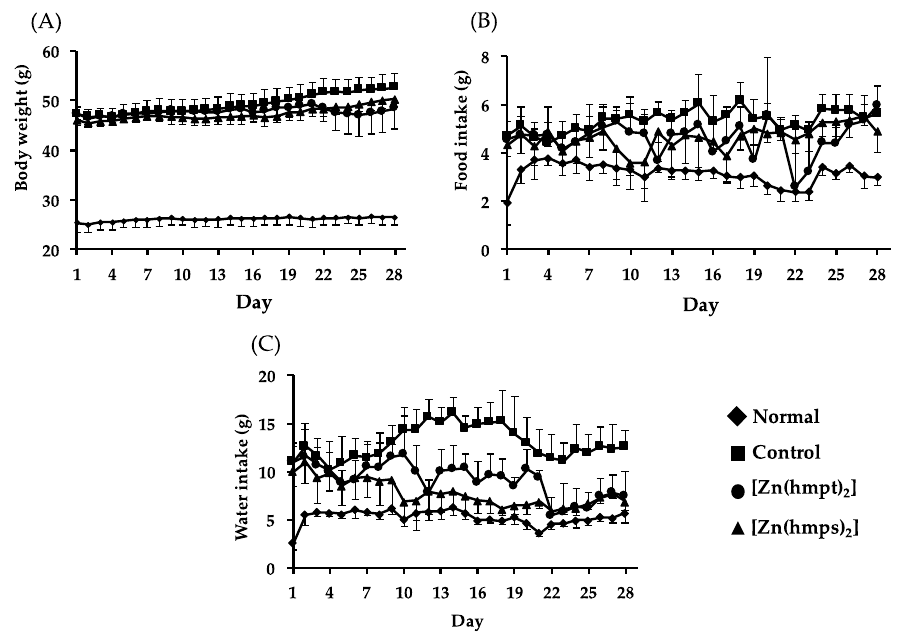
Figure 3. Changes in body weight ( A ); food intake ( B ); and water intake ( C ) over 28 days in normal, control (PEG-400 administered), [Zn(hmpt) 2 ]-treated, and [Zn(hmps) 2 ]-treated mice; data are expressed as the means ± SDs for 6–8 mice.